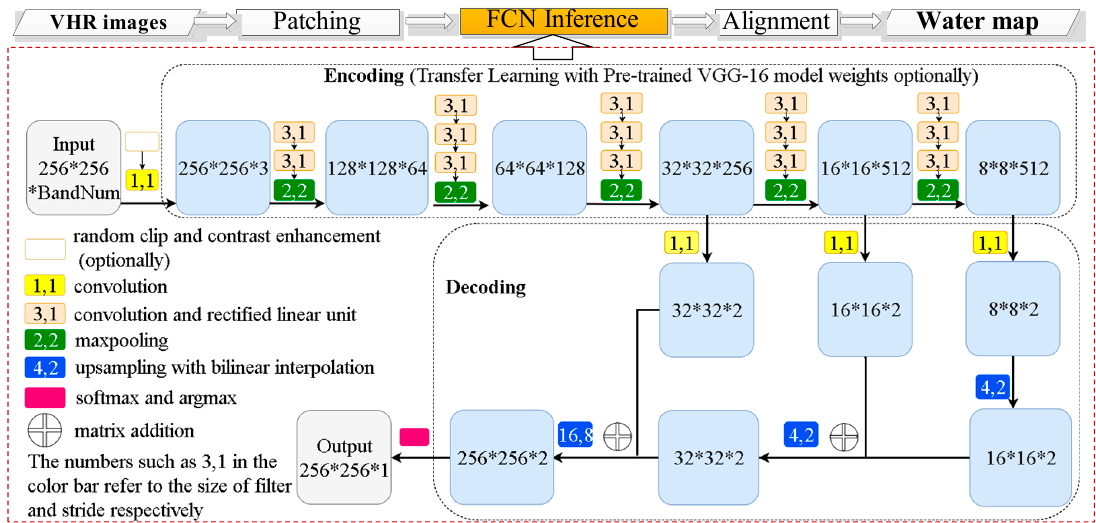
Figure 2. Illustration of the FCN-based method. The top refers to the main procedure; the bottom refers to the FCN model. In the model, the large blue boxes refer to intermediate features whose sizes are shown in each box. Each color bar above the main connector represents a specific module whose function is indicated by its color and is explained at the lower-left corner.